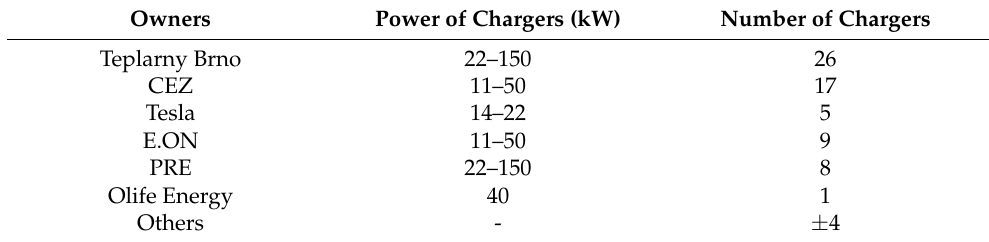
Table 1. Parameters of EV chargers in Brno.